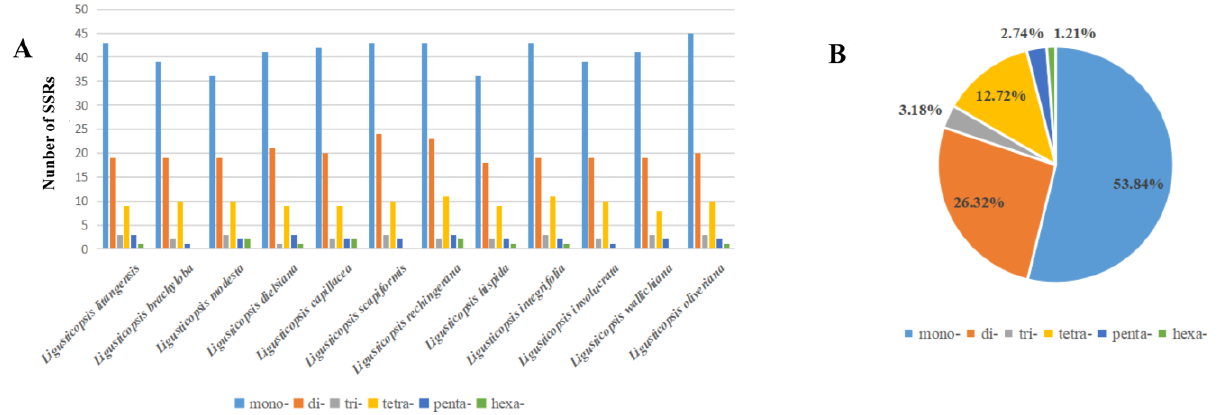
Figure 8. Analyses of simple sequence repeats (SSRs) in twelve plastomes. ( A ) Numbers of different repeat types; ( B ) the proportion of different SSR types in total. repeat types; ( B ) the proportion of different SSR types in